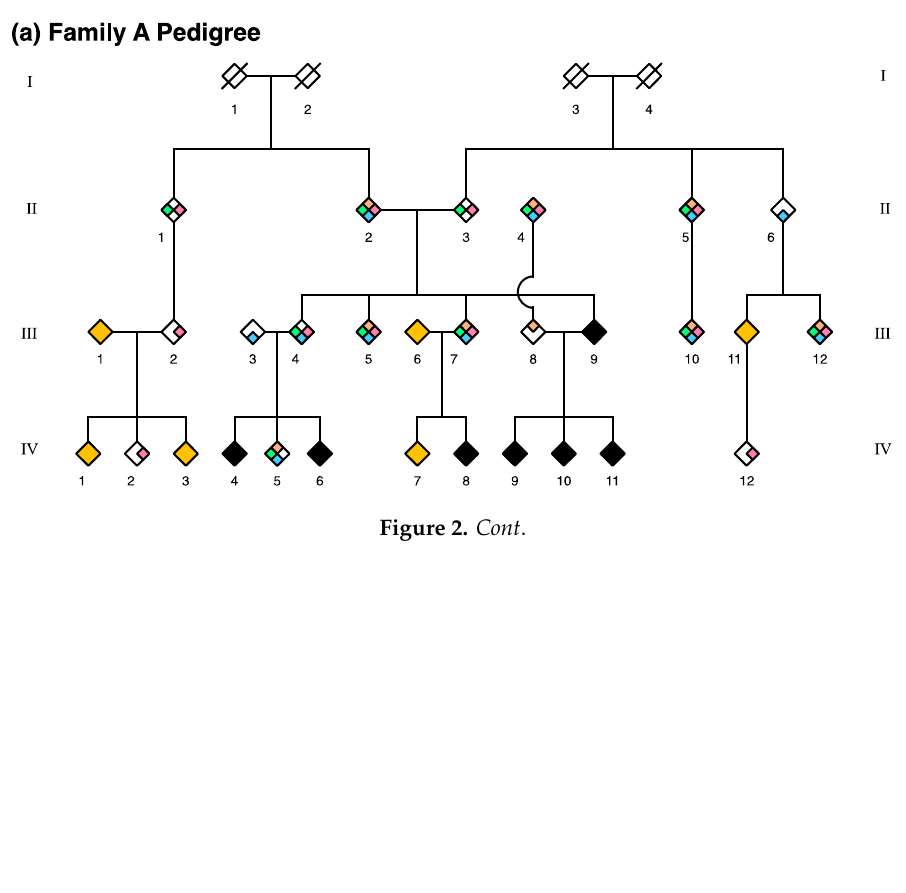
Figure 1. Number of BAP endophenotypes present in Family A and B. Individuals married-in to Family A tend to have a single endophenotype indicating a milder BAP presentation, in contrast with core family members who have multiple endophenotypes (obsessive most frequent). In Family B, married-in and core family members tend to have more than one endophenotype, with the aloof endophenotype the most frequent.